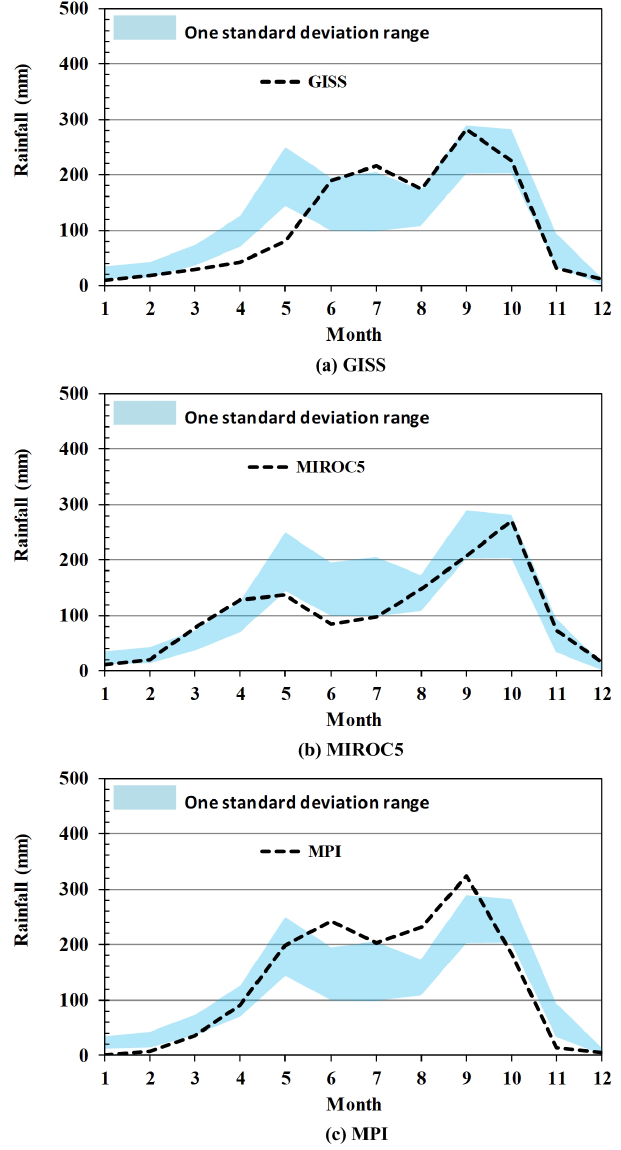
Figure 4. Comparison of mean monthly precipitation variation